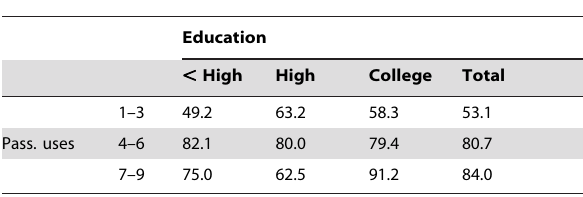
Table 5. Percentage of participants reporting